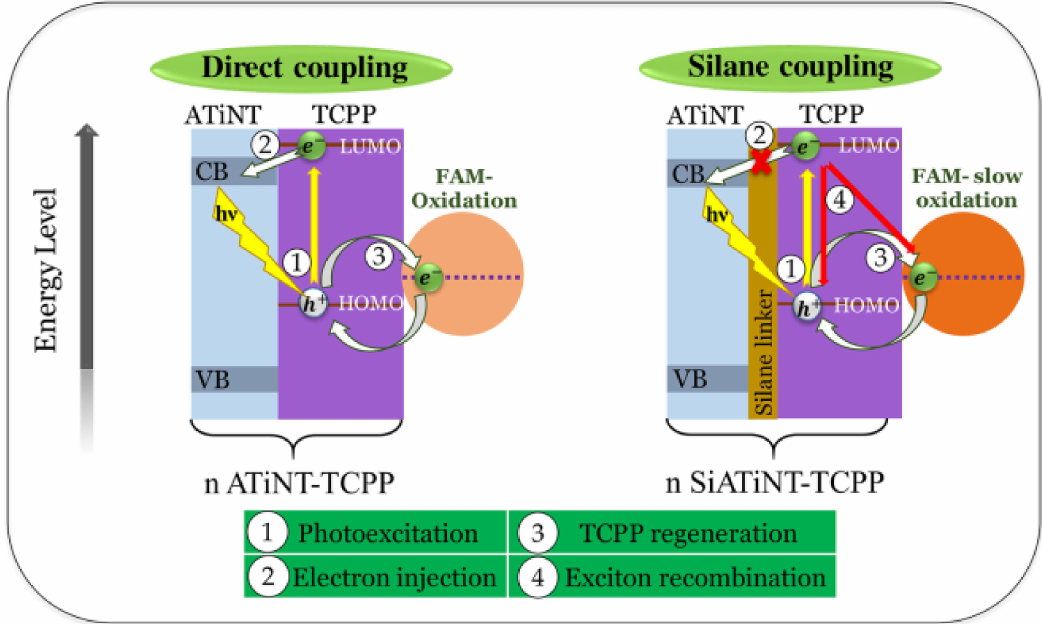
Figure 15. Schematic illustration of the proposed visible-light photocatalysis mechanism for FAM degradation using TCPP@ATiNT and TCPP@Si-ATiNT . Adapted with permission from ref [75]. Copyright 2020